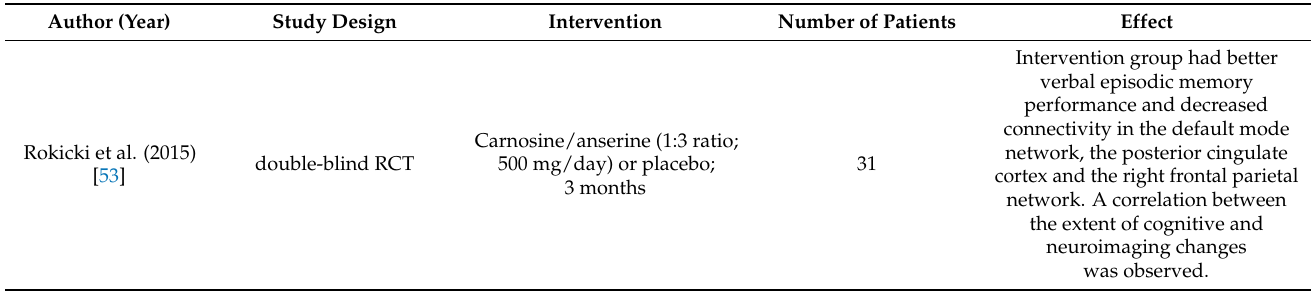
Table 2. Carnosine, beta-alanine and neurological